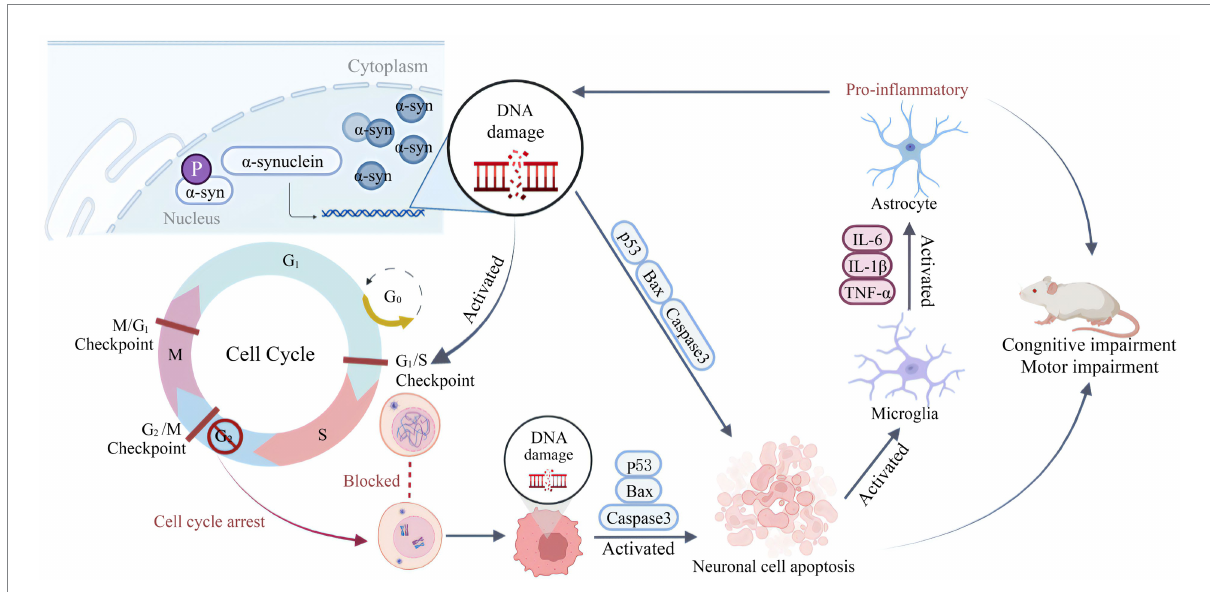
FIGURE 10 Schematic diagram for summarizing the behavioral impairment in mice caused by overexpression of α -syn in hippocampal neuron nuclei. The nuclear overexpression of α -syn causes DNA damage in hippocampal neurons, and leads to cell cycle activation and abnormal blockade, further induced hippocampal neuronal apoptosis and inflammatory response. Then the inflammation further aggravates DNA damage, creating a vicious cycle that ultimately promotes cognitive impairment and motor impairment in mice. The schematic illustration was drawn according to BioRender